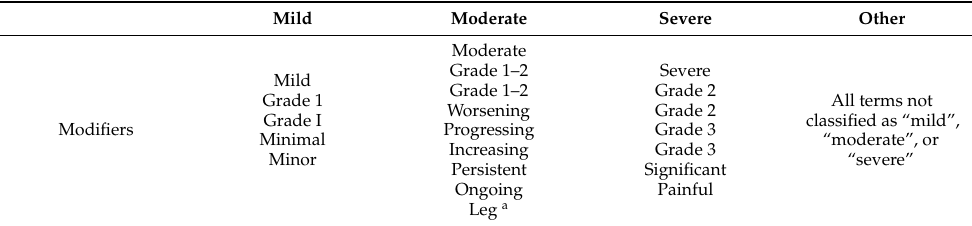
Table A1. Classifying neuropathy terms into severity categories with term